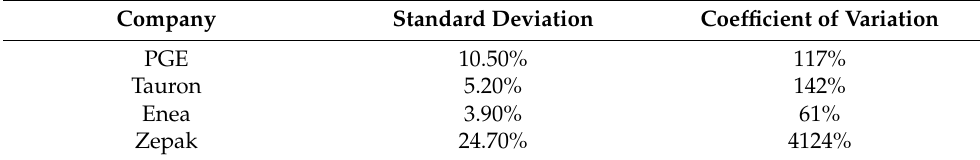
Table 4. Coefficients of variation and standard deviations for ROS of the surveyed companies.